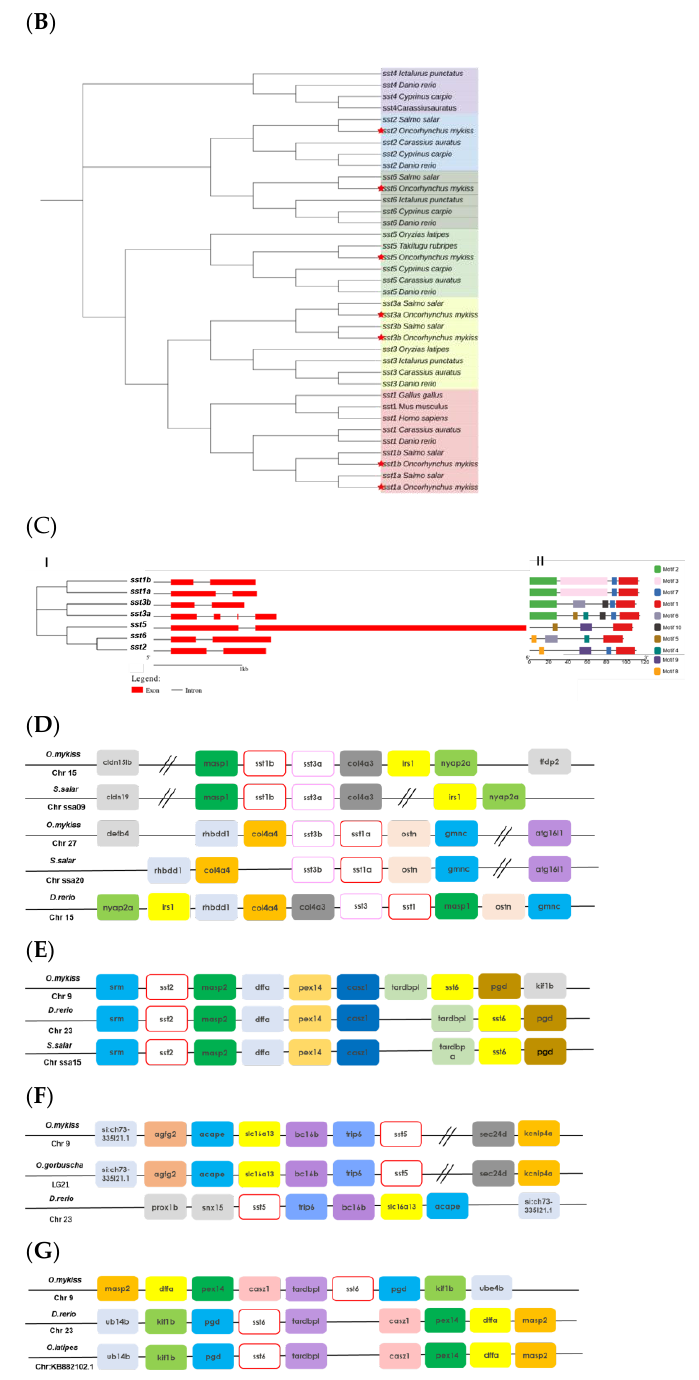
Figure 1. Chromosomal distribution, phylogenetic, syntenic analysis of sst genes in rainbow trout. ( A ) The chromosomal localization of sst genes. ( B ) Phylogenetic tree of the SST family in vertebrate. The amino acid sequences were analyzed via a neighbor-joining method with 1000 bootstrap repli- cations. Rainbow trout SSTs are highlighted by a red pentacle. ( C ) Gene structure and protein motif of SST proteins of rainbow trout. (I) Exon and intron structures of SST proteins in rainbow trout. Phylogenetic tree was constructed by a neighbor-joining method with 1000 bootstrap replications. (II) Protein motif analyses of SST proteins in rainbow trout. Eight specific motifs were found in SST proteins of rainbow trout, different colors represent different motifs. ( D – G ) Conserved syntenic analyses of sst genes: sst1a / b and sst3a / b (1D); sst2 (1E); sst5 (1F); sst6 (1G). sst genes are shown by the same color. The double slash represents the omission of more than two